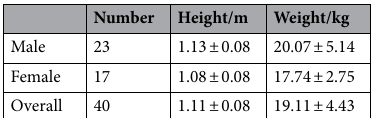
Table 1. Basic information of participated children in this